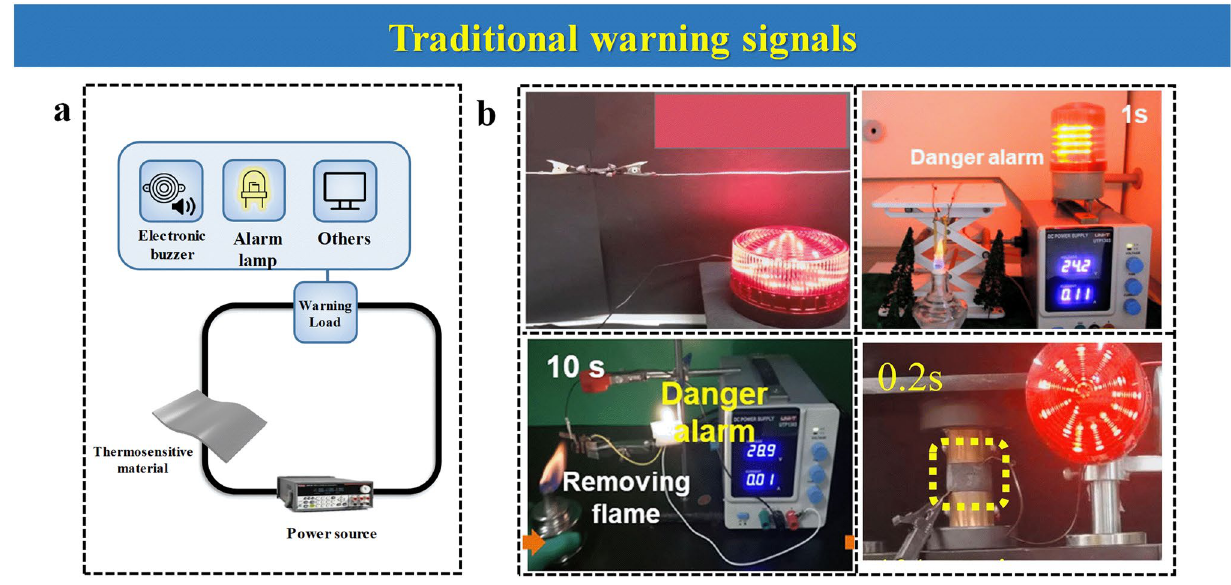
Fig. 14 a Traditional warning signals comprising alarm lamp or electronic buzzer in fire alarms. b Examples of traditional warning alarms. Reproduced with permission from Refs. [40, 60, 69, 88]. Copyright Elsevier